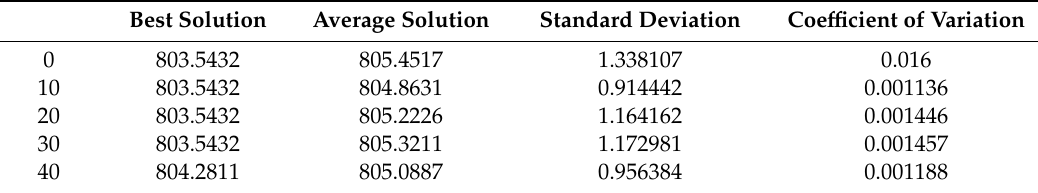
Table 3. Parameters of no_impr in path